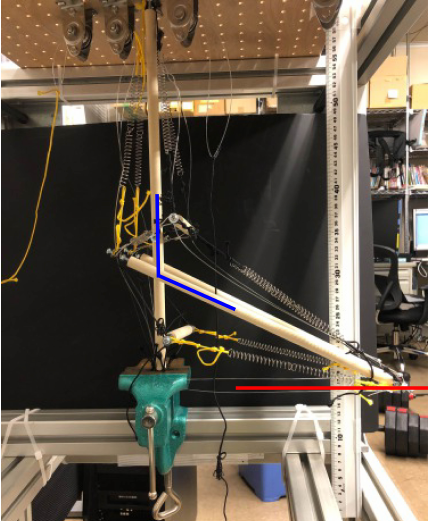
Figure 10. The environment to measure the range of motion of the tip. The red line is the height of the tip. The angle formed by the blue lines was